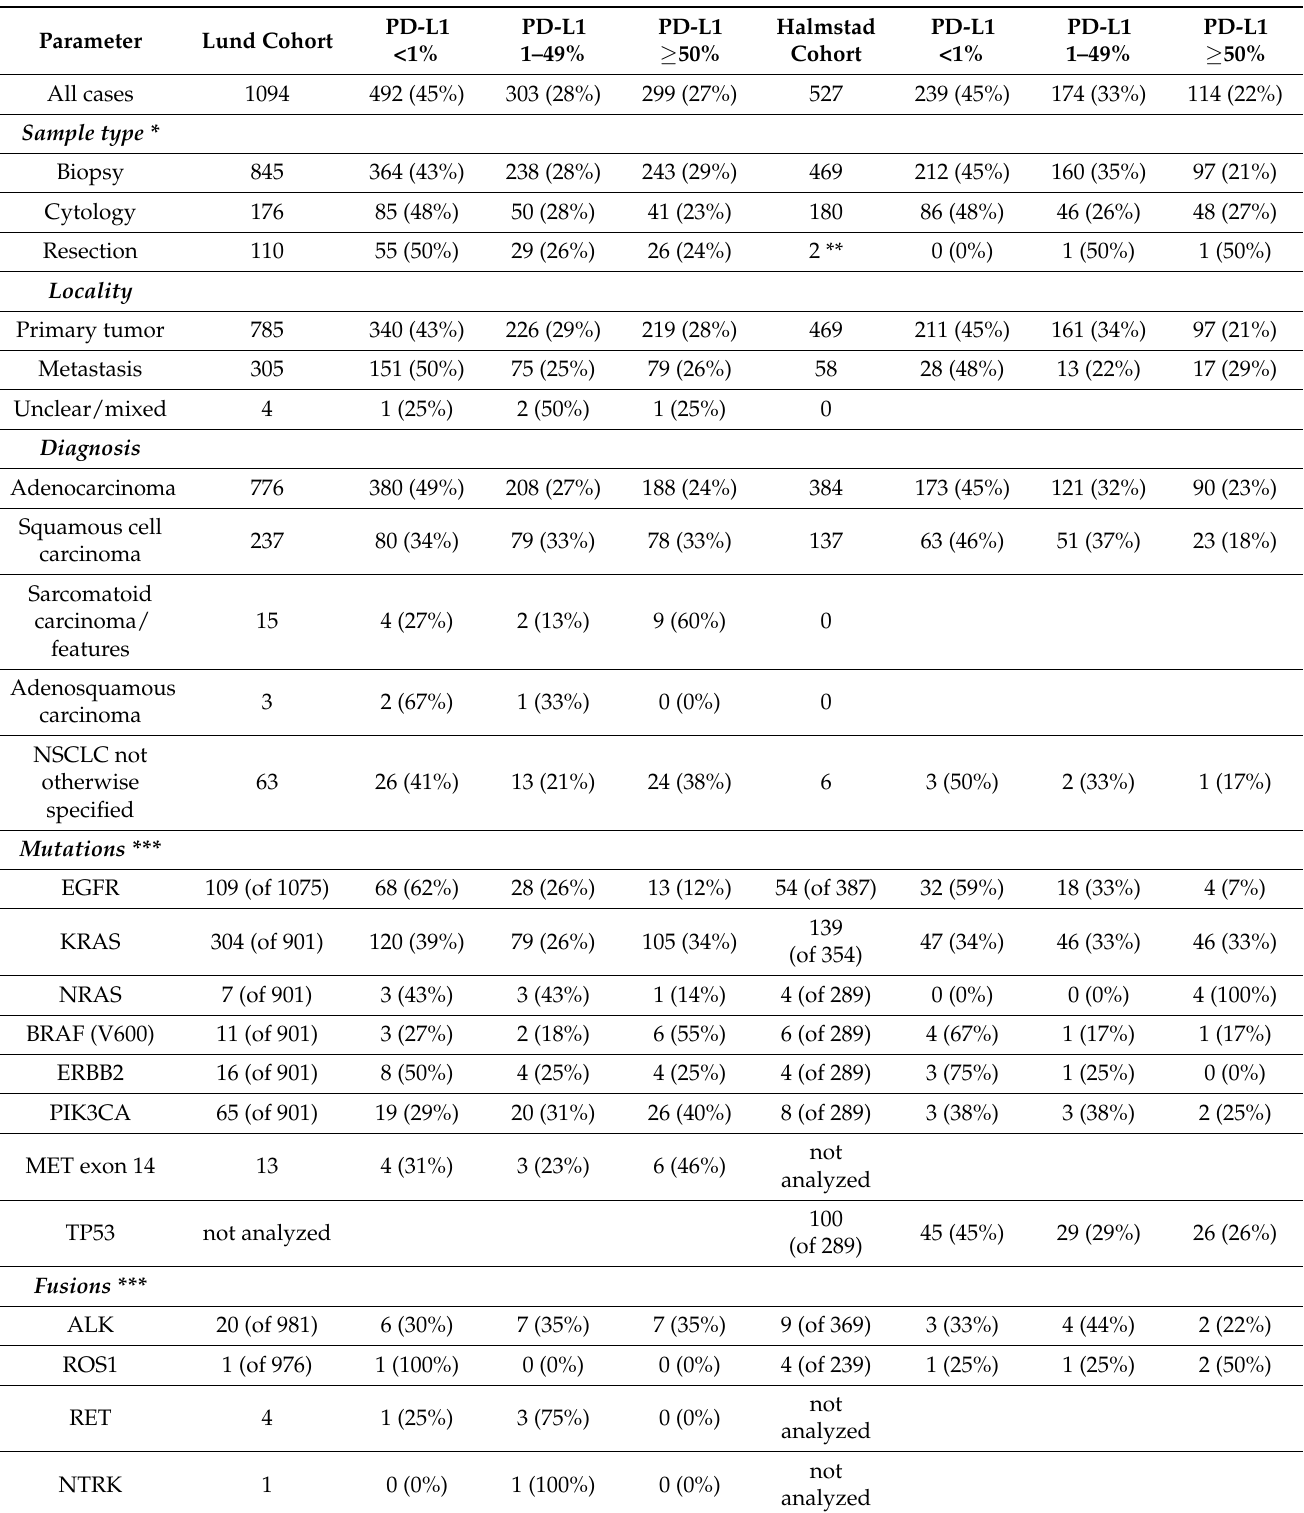
Table 1. PD-L1 expression and relation to various parameters in two cohorts of non-small cell lung cancer